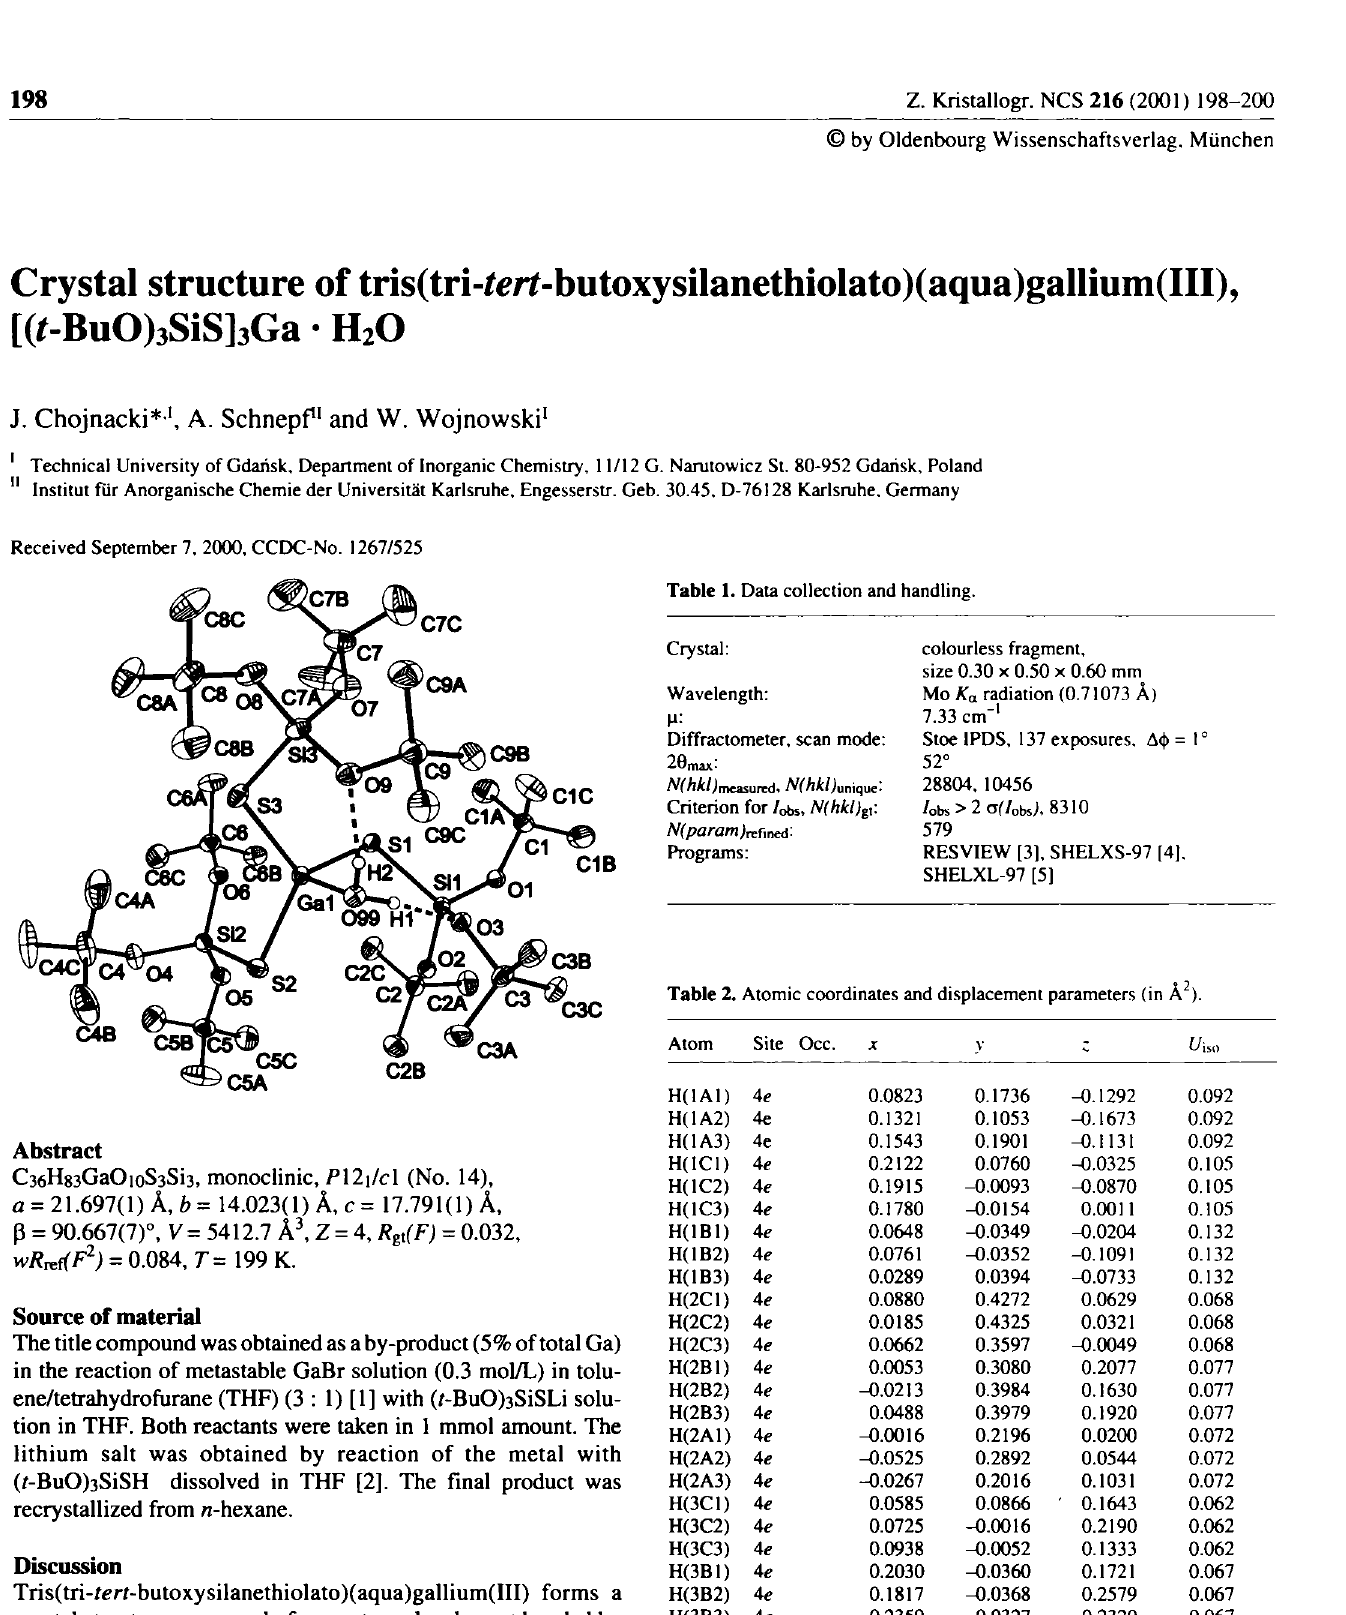
Table 2. Atomic coordinates and displacement parameters (in Ä 2